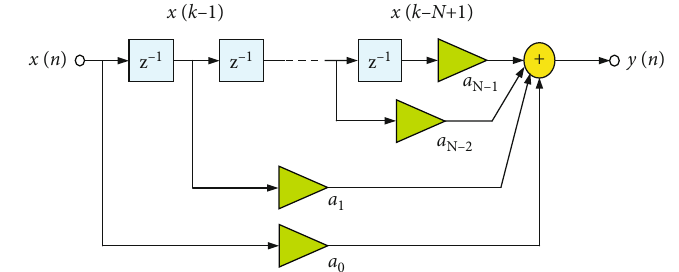
Figure 6: Implementation principle of FIR.